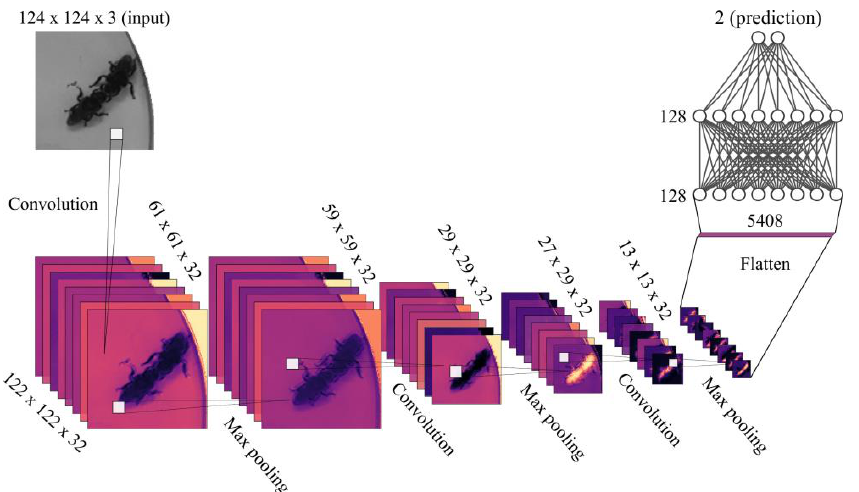
Figure 3. Convolutional neural network architecture defined after hyperparameter optimization (Appendix B) to recognize animal complex behavior on Ethoflow. This model was configured with stochastic gradient descent (learning rate at 0.0001 and momentum at 0.9) as an optimizer and binary cross-entropy as a loss function. Batch normalization was applied before max-pooling layers. Dropout was also applied after dense inner layers. In the inner layers (convolutional or dense), the function activation was Elu. The dimensions (width × height × depth) of feature map are given in each layer; the output dimensions of a layer are the same as the input dimensions of the next layer. In the flatten process, the data are transformed into a vector to enter the dense layers. In the last dense layer, a sigmoid function is applied, which gives the binary output.